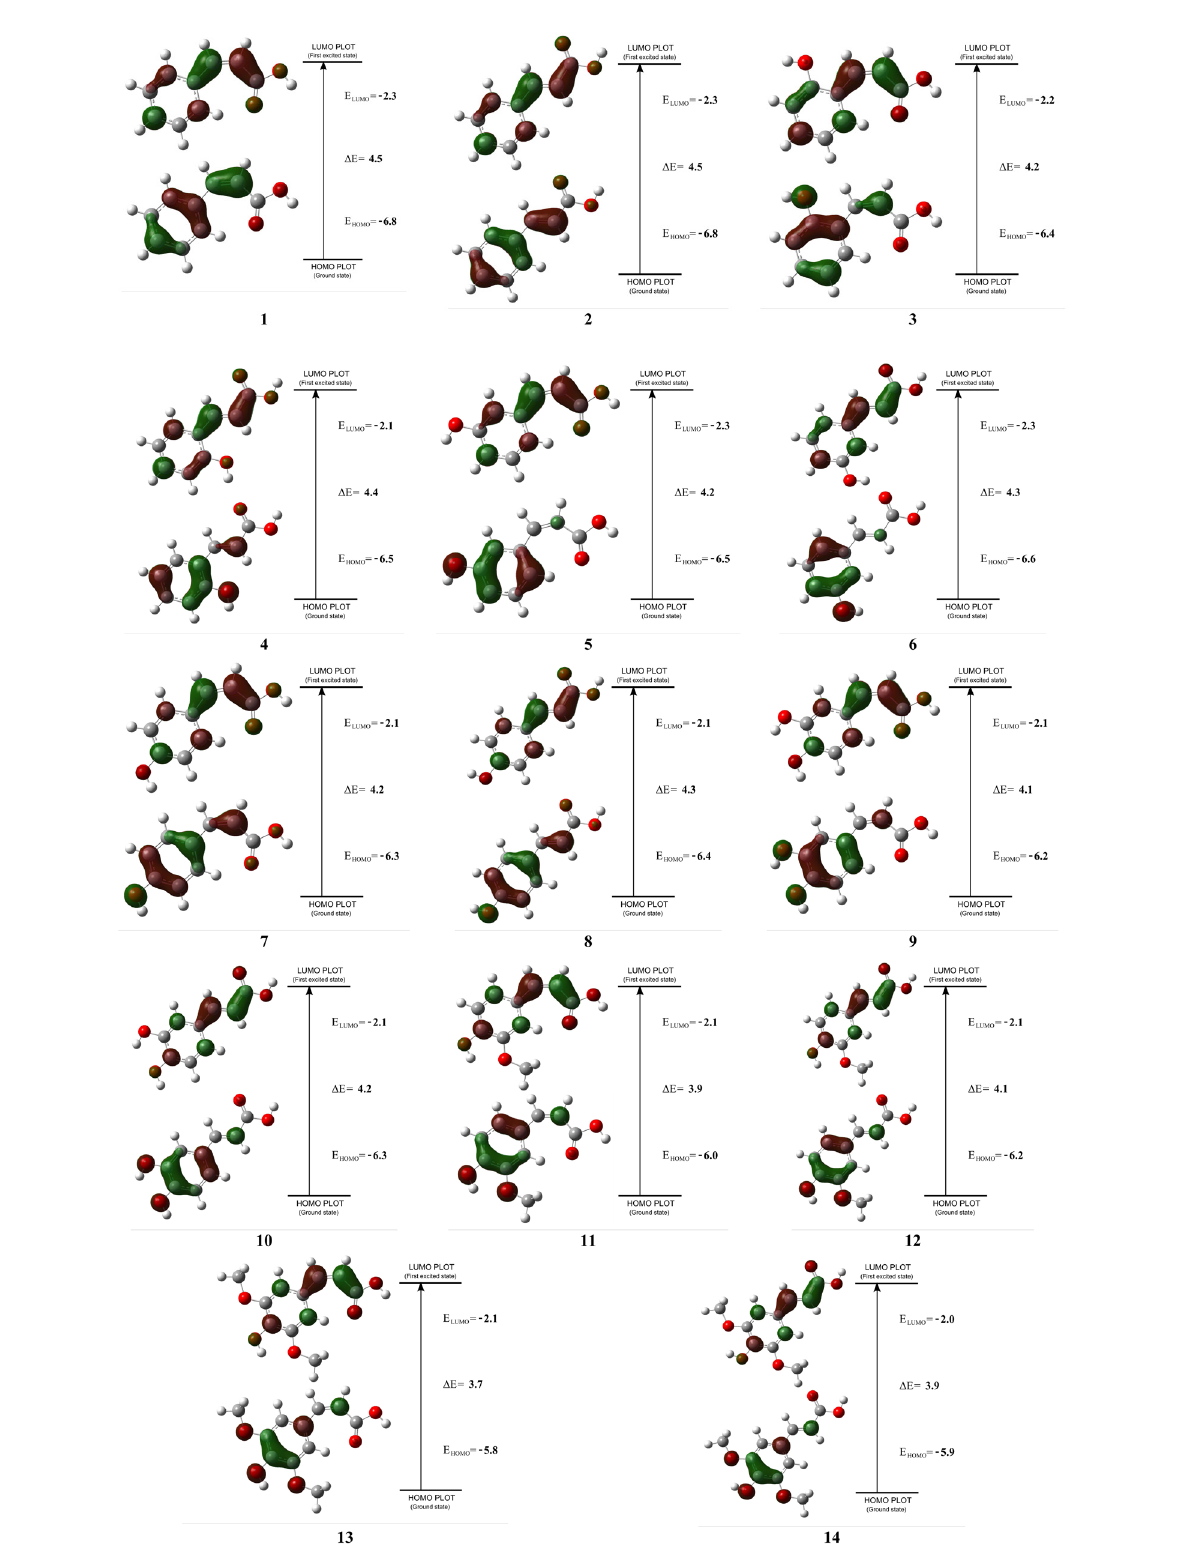
Figure 3: The rB3LYP/6-311++G(2d,2p) atomic orbital compositions of the frontier molecular orbital for (1) c -CiA, (2) t -CiA, (3) c - o -CA, (4) t - o -CA, (5) c - m -CA, (6) t - m -CA, (7) c - p -CA, (8) t - p -CA, (9) c -KA, (10) t -KA, (11) c -FA, (12) t -FA, (13) c -SA, (14) t -SA in vacuum. The calculations for canonical MOs were accomplished with isovalue